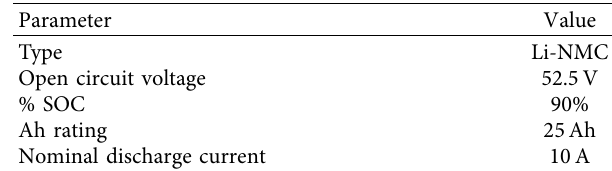
Table 3: Battery